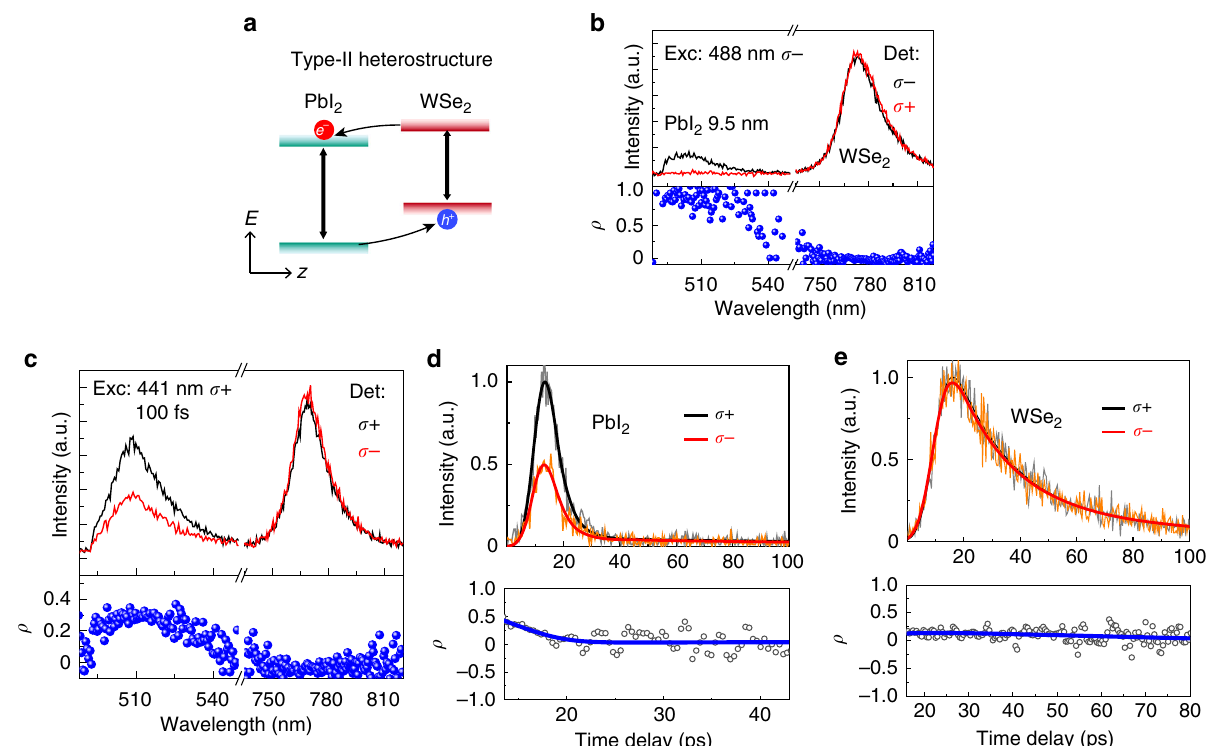
Fig. 5 Degree of spin polarization and the dynamics in PbI 2 /WSe 2 heterostructures. a Schematic of the type-II band alignment and the corresponding photogenerated carrier behaviors in PbI 2 /WSe 2 heterostructures. b Circularly polarized PL spectra from a 9.5 nm thick PbI 2 /WSe 2 heterostructure, and the corresponding calculated ρ as a function of wavelength. The excitation is 488 nm σ − polarized CW laser. c – e Circularly polarized PL spectra ( c ) and TRPL data from PbI 2 ( d ) and WSe 2 ( e ) in PbI 2 /WSe 2 heterostructure, and the corresponding degree of polarization ρ calculated from PL and TRPL spectra. Excitation with 441 nm σ + polarization femtosecond laser